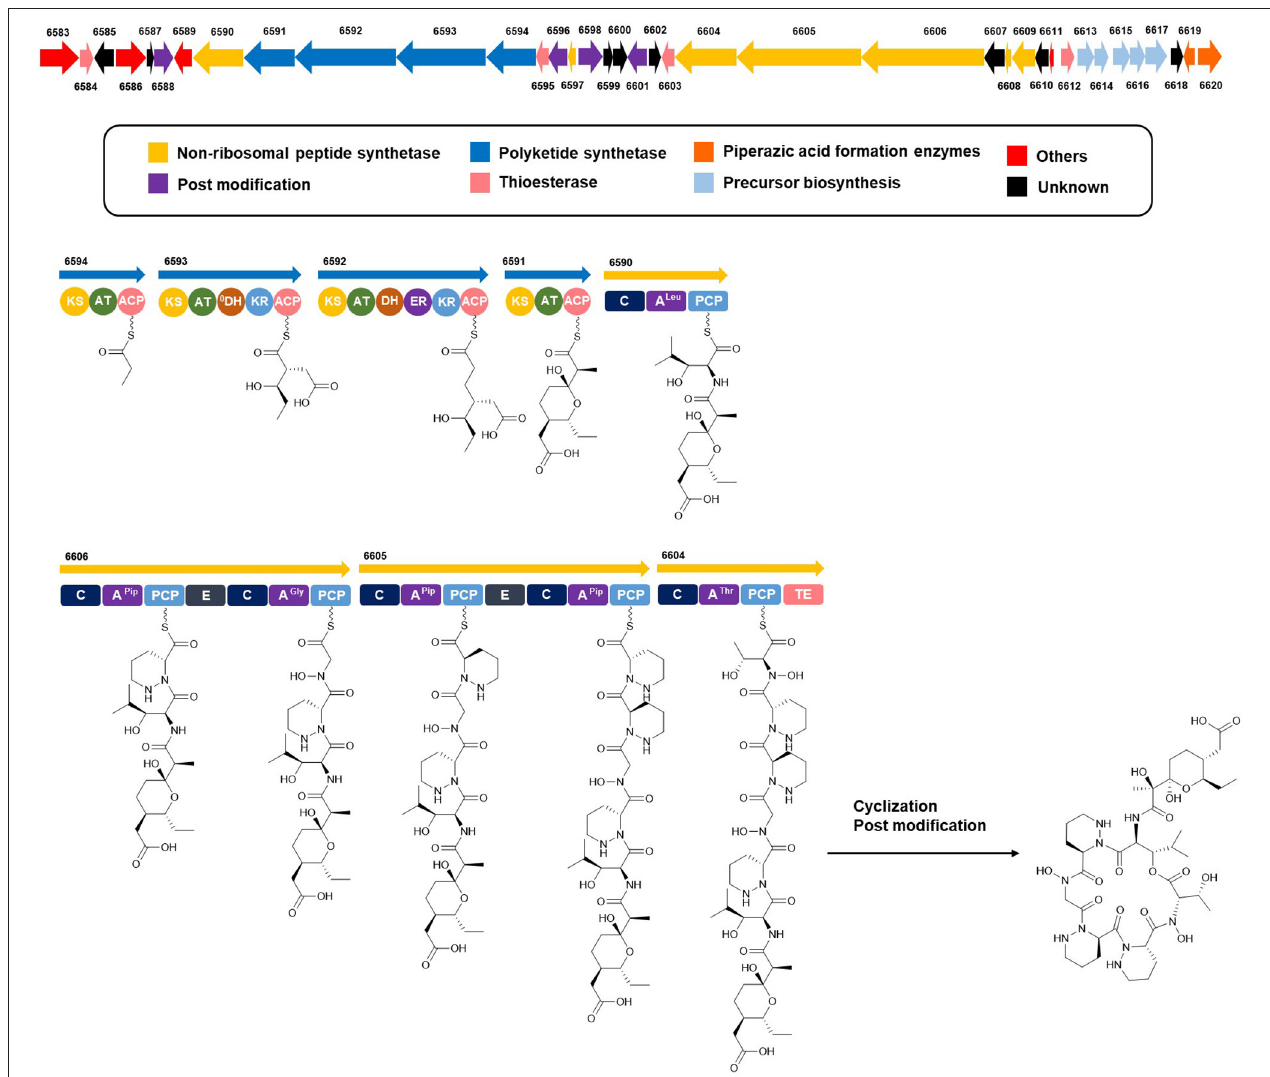
FIGURE 5 | Putative biosynthetic gene cluster and proposed biosynthetic pathway of dentigerumycin E ( 1 ).